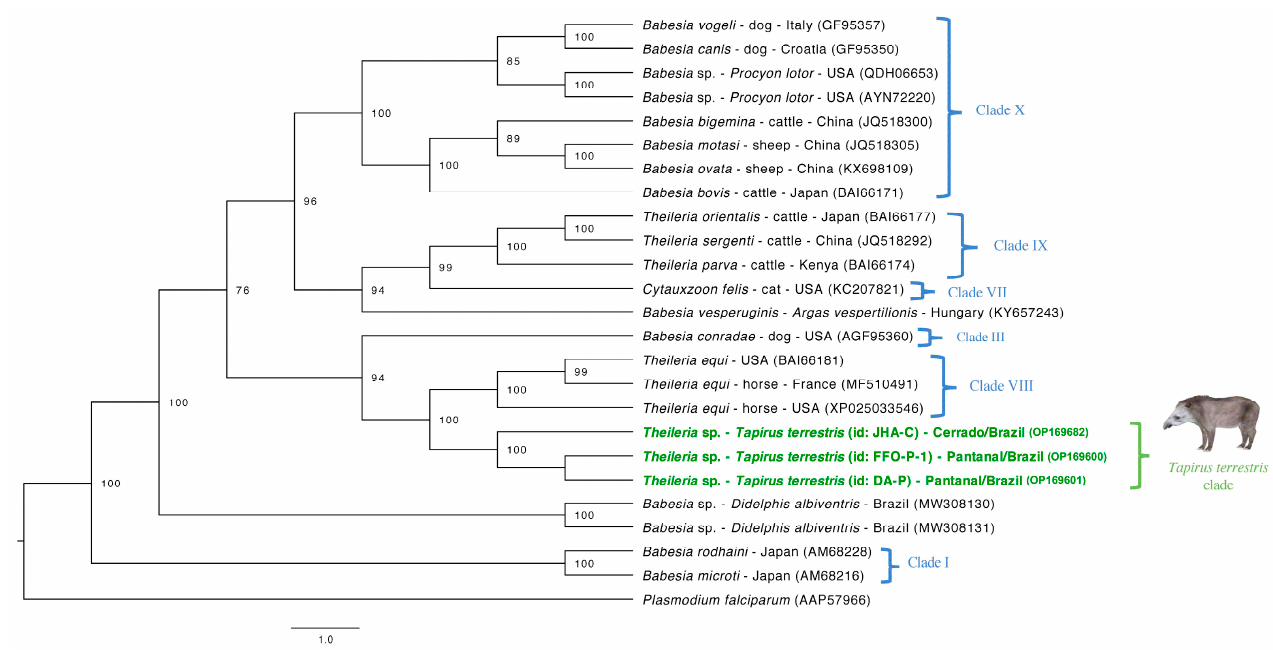
Figure 3. Phylogenetic tree based on partial cox -1 gene. Tree was constructed by Bayesian inference using an alignment size of 259 amino-acids. A sequence of Plasmodium falciparum (AAP57966) was used as outgroup. Sequences from the present study are highlighted in red. Post probability values >50 appear in tree. Clades (I, III, VII, VIII, IX, X) were identified according to the phylogenetic study